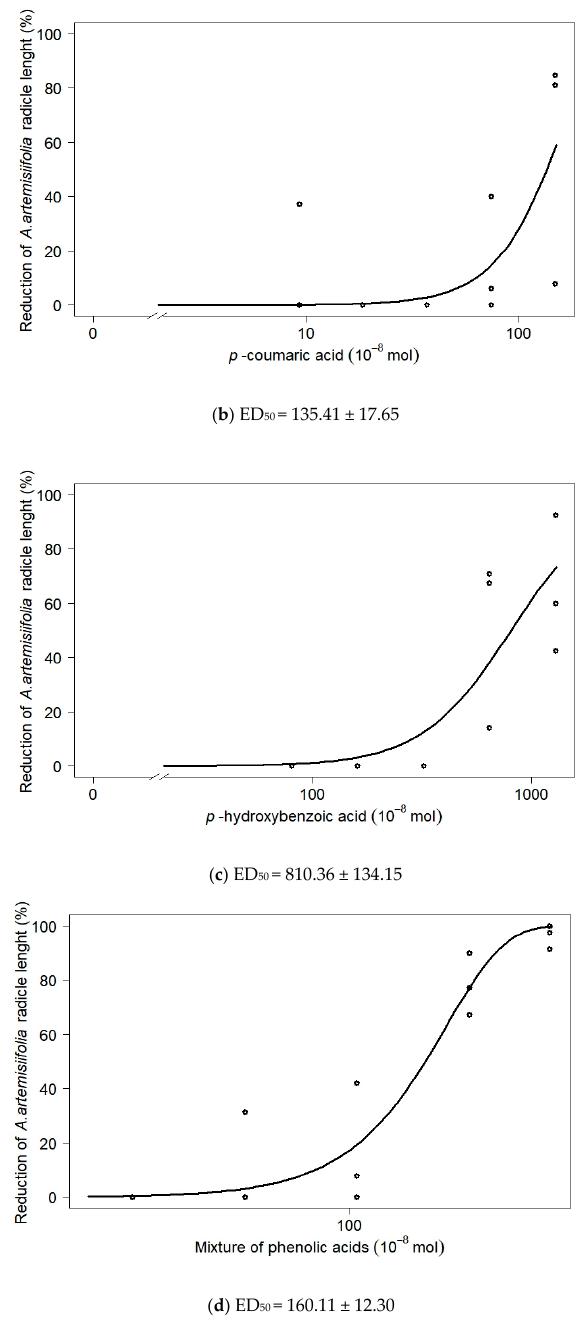
Figure 1. Log-logistic dose–response curve depicting radicle length reduction in A. artemisiifolia seedlings when treated with ( a ) ferulic acid, ( b ) p ‐ coumaric acid, ( c ) p ‐ hydroxybenzoic acid, or ( d ) mixture of all nine phenolic acids (estimated value ± standard error, ×10 − 8 mol). The dots represent observed data, while the solid curve represents the response predicted by non ‐ linear regression.